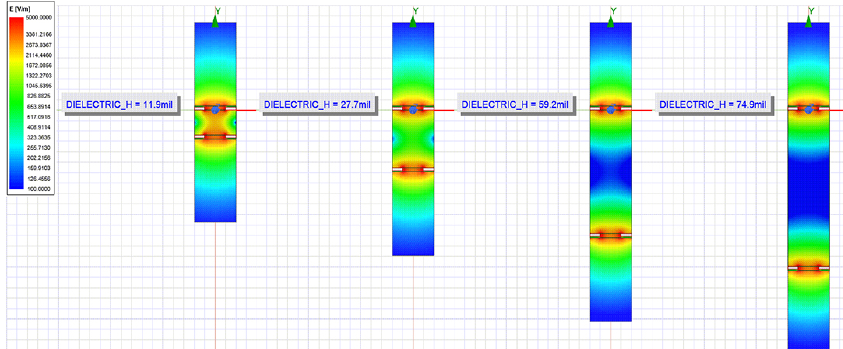
Figure 15. Electric Field distribution between the traces of the capacitive sensors for different thicknesses of the FR4 dielectric. One trace is positively charged and the other is negatively